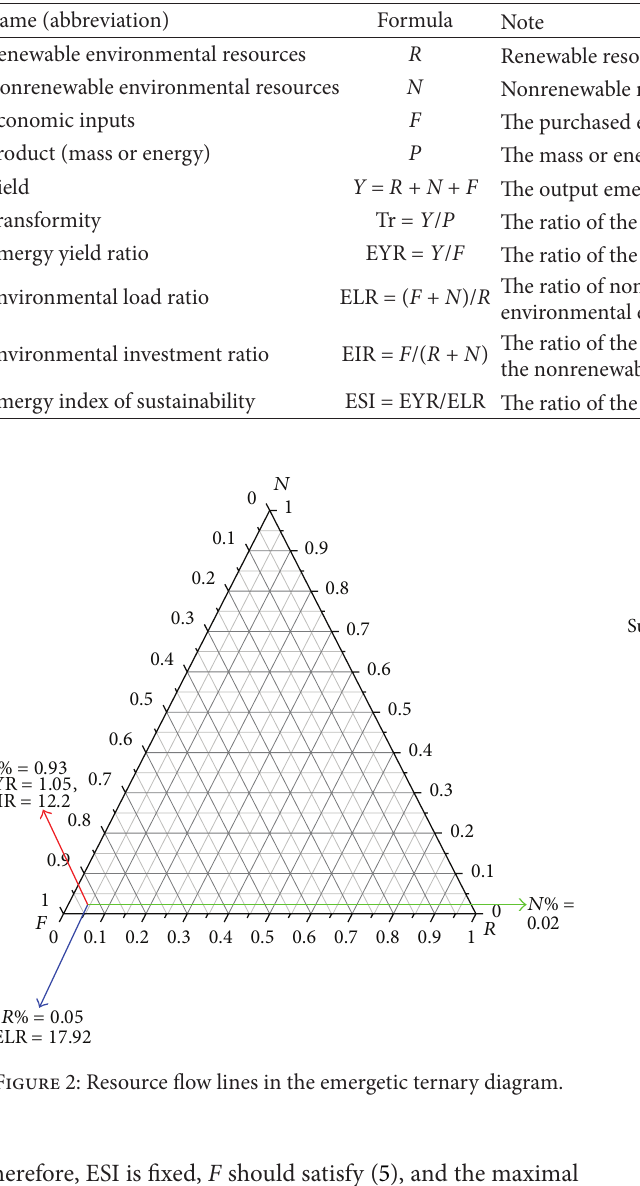
Table 1: Emergy indices and corresponding calculated methodology used in this paper.